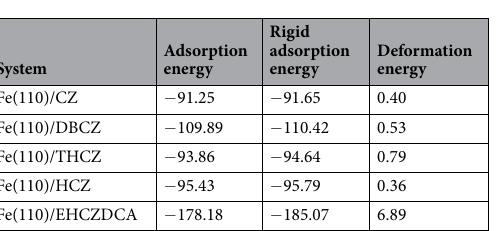
Table 9. Energy parameters (kcal/mol) associated with the adsorption of the inhibitor molecules on